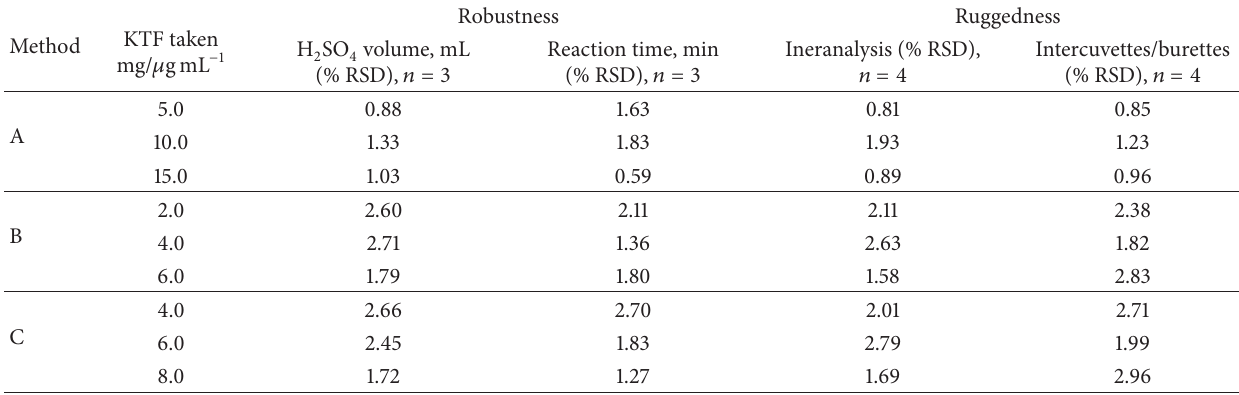
Table 4: Method robustness and ruggedness expressed as intermediate precision.